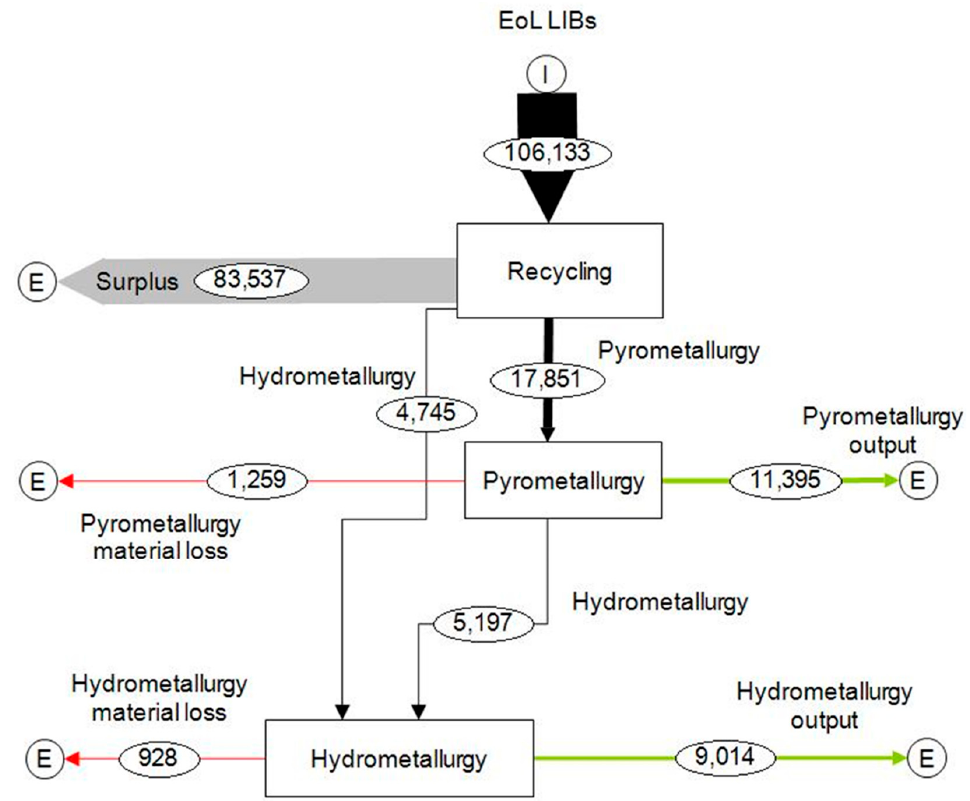
Figure 2. Material flow analysis of European electric vehicles fleet that will reach end of life in 2030 and performance of European LIBs recycling (data are expressed in k tons) (I: input flow, E: exit flow). Pyrometallurgy is the most applied technology in full scale recycling plants (Table